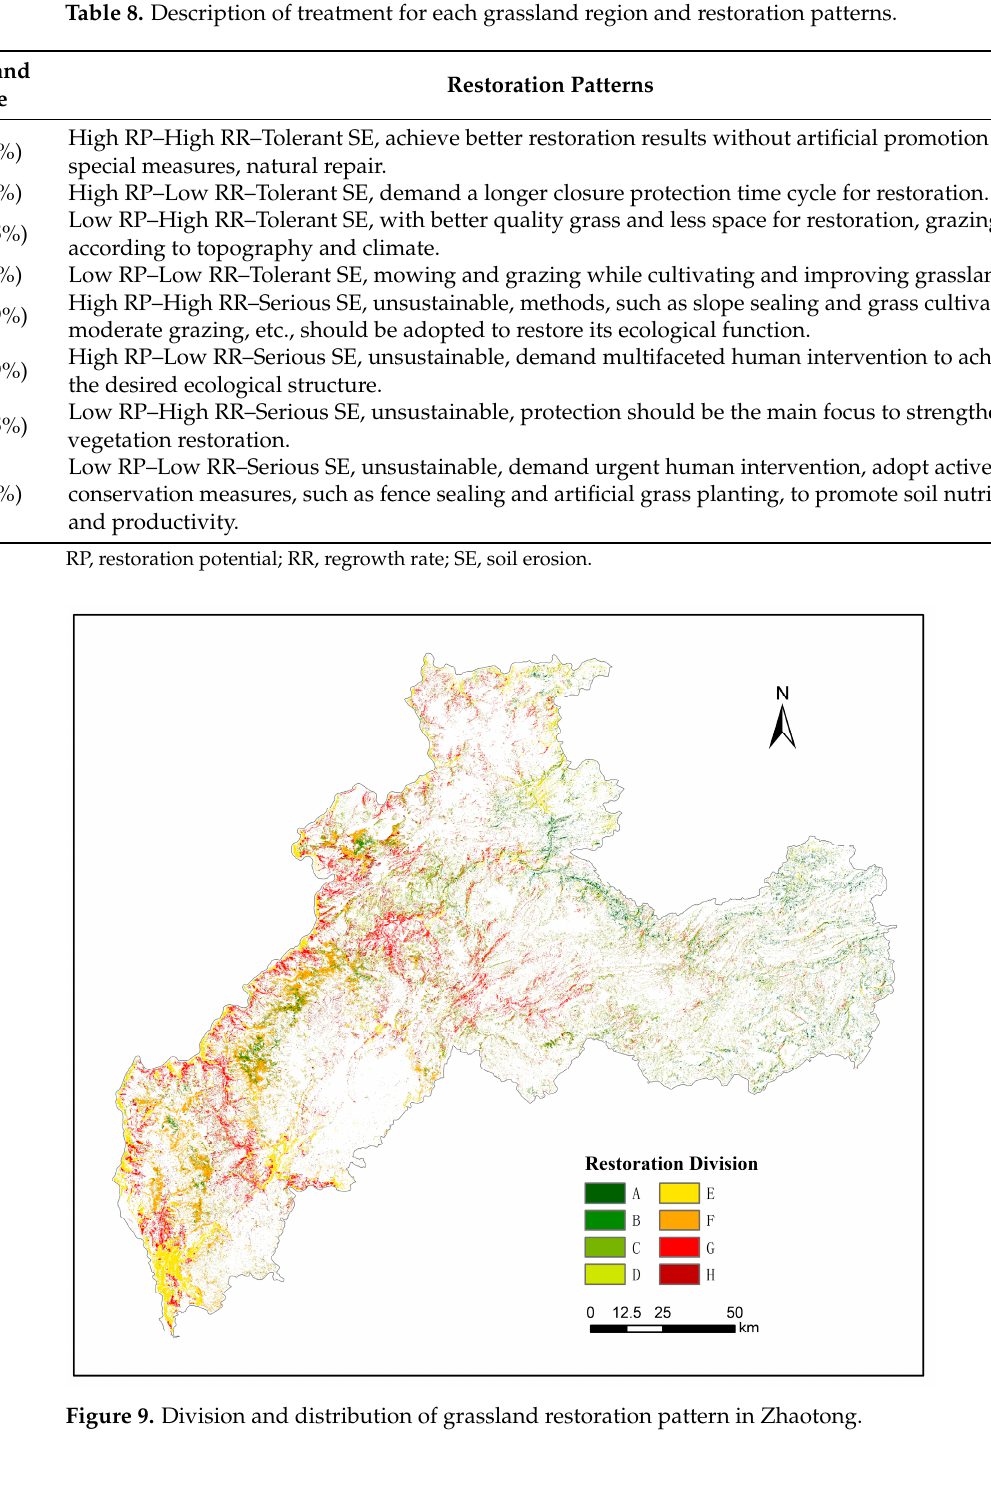
Table 8. Description of treatment for each grassland region and restoration patterns.